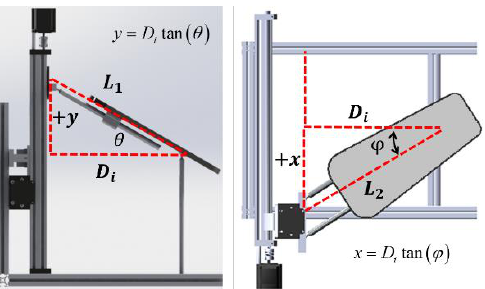
Figure 14. Relation between linear displacement vs ankle rehabilitation angle. Table 6. Relation between the displacement of the linear guide vs angle movement. Dorsiflexion (DF)